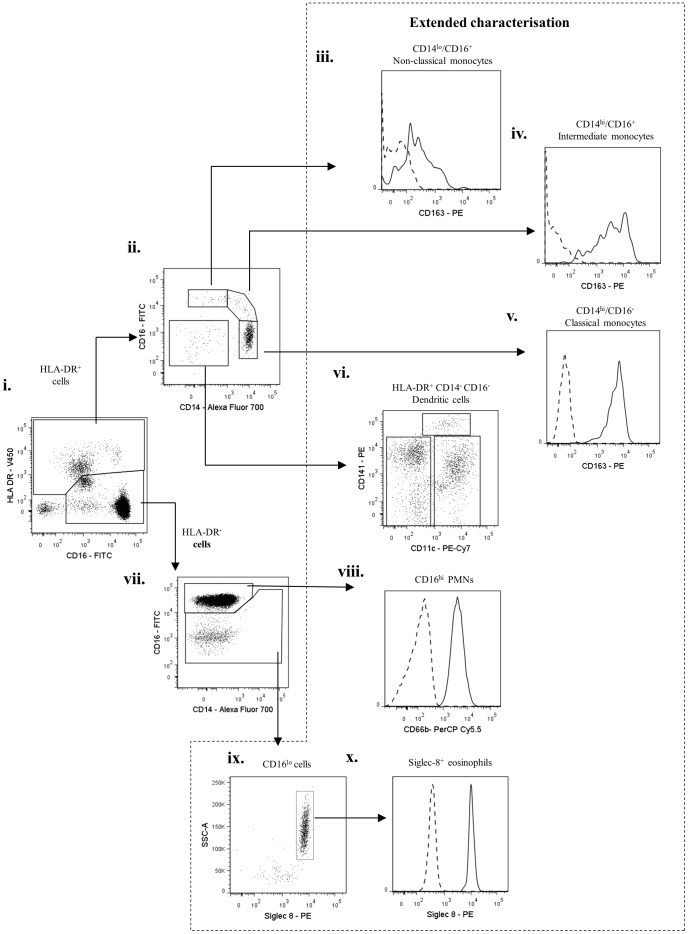
Characterisation of peripheral blood leukocytes from healthy volunteers- II.HLA-DR+ and HLA-DR− cells identified in Figure 1 were further analysed. HLA-DR+ cells were characterised into CD14hi/CD16− , CD14hi/CD16+, CD14lo/CD16+ monocytes and CD14−/CD16− dendritic cells. HLA-DR− cells comprised of typical PMNs (CD16hi, CD66+) and a CD16lo population. On extended characterisation, HLA-DR−/CD16lo cells were identified as Siglec-8+ eosinophils and the HLA-DR+/CD14−/CD16− dendritic cells comprised of CD141+ and CD11c+ dendritic cell subpopulations. Arrows indicate gating strategy.